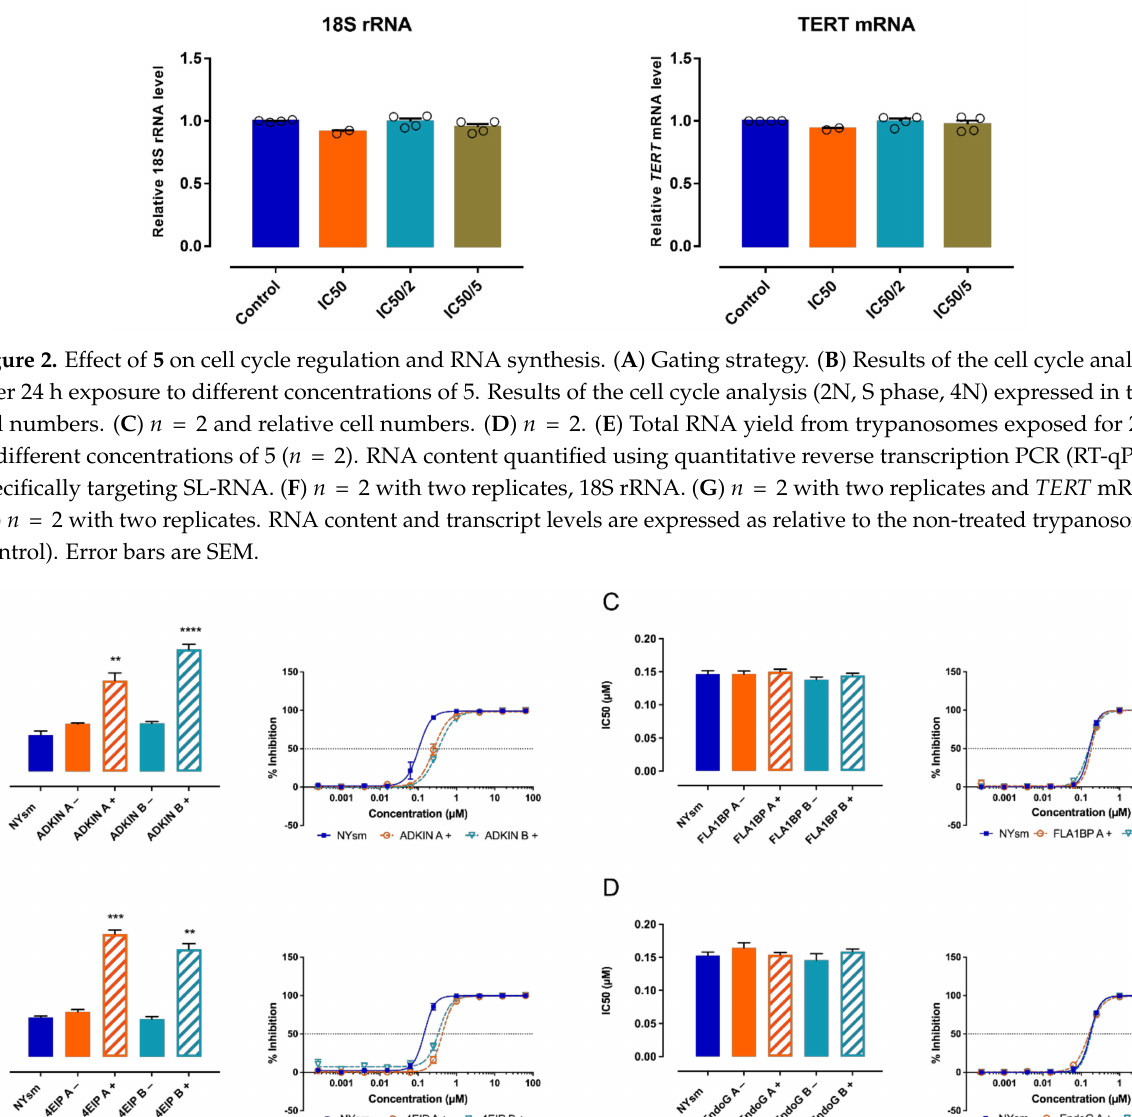
Figure 3. Drug susceptibility of RNAi clones targeting ( A ) ADKIN, ( B ) 4EIP, ( C ) FLA1BP, and ( D ) EndoG to 5 . Results are expressed as the mean IC 50 ( µ M), and error bars represent SEM, and are based on at least two independent experiments ( n = 2), each with two biological replicates. + = tetracycline-induced clones; − = non-induced clones. All experiments were performed with two independently generated RNAi clones. ** p < 0.01, *** p < 0.001, **** p < 0.0001 Kruskal–Wallis test with Dunn’s multiple comparison